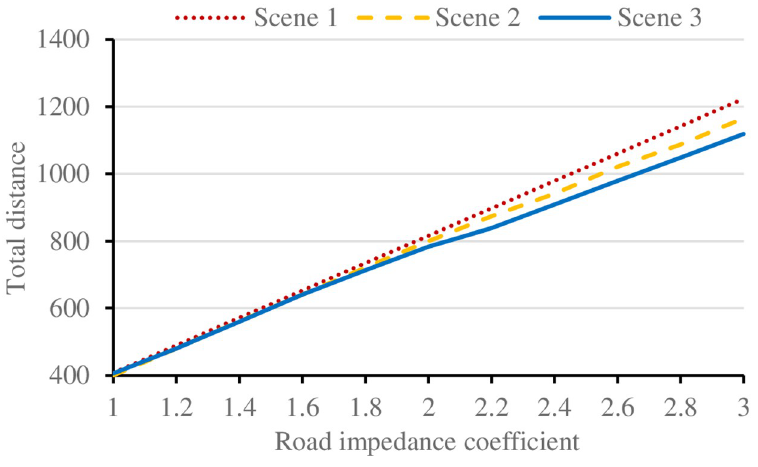
Fig 10. Results under different impedance